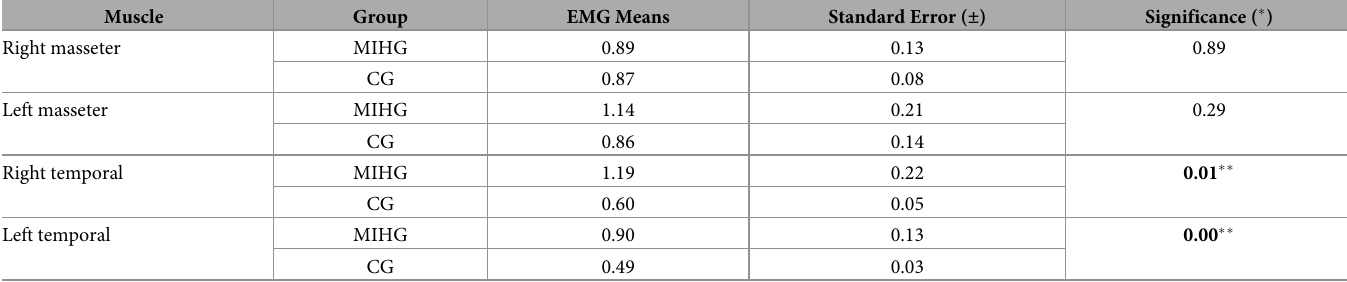
Table 8. Mean values, standard error, and statistical significance (p � 0.05) of the normalized electromyographic data in the habitual mastication of soft food con- dition, for each muscle evaluated, in the MIH Group (MIHG) and Control Group (CG). Muscle